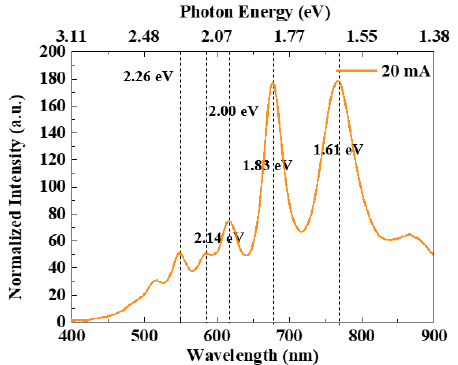
Figure 6. Electroluminescence spectra of the light source.